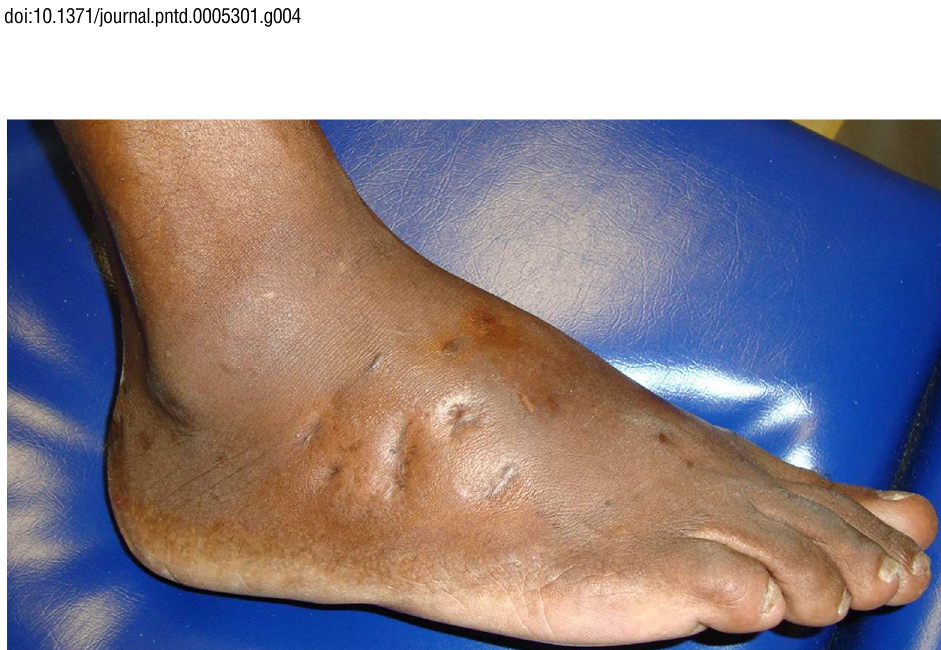
Fig 5. Right foot affected with actinomycetoma after treatment.